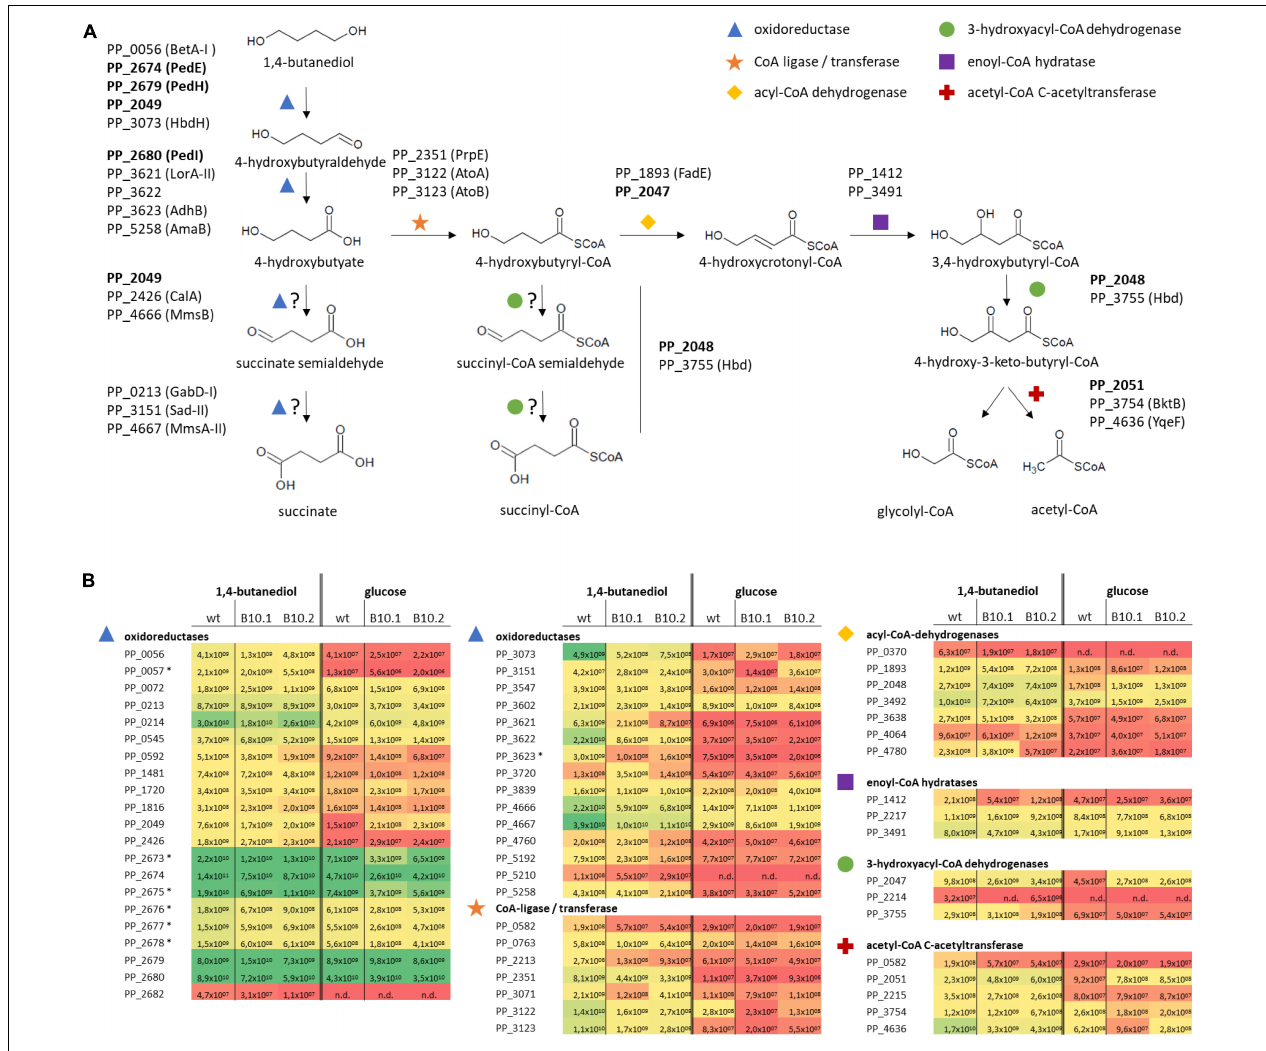
FIGURE 3 | Hypothetical pathways for 1,4-butanediol metabolism (A) and expression levels (Label Free Quantification, LFQ; Tyanova et al., 2016) representing the sum of the ion signal recorded in the mass spectrometer for all peptides derived from each protein of the corresponding proteins (B) . Colors correspond to LFQ levels, red for low, yellow for average, and green for high values. Proteins which are strongly upregulated in response to growth on MSM with 1,4-butanediol compared to growth with glucose, or which have high expression level in all tested conditions, are indicated in (A) , with proteins further investigated in this work in bold. Protein expression levels (B) of selected proteins for P. putida KT2440 and the evolved strains B10.1 and B10.2 growing in MSM with glucose or 1,4-butanediol are listed as oxidoreductases (blue triangle), CoA-ligases (orange star), acyl-CoA dehydrogenases (yellow diamond), 3-hydroxyacyl-CoA dehydrogenase (green circle), enoyl-CoA hydratases (purple rectangle), and acetyl-CoA C-actyltransferase (red cross). n/d, not detected. In case of operons, associated transporters or accessory proteins are included, marked with